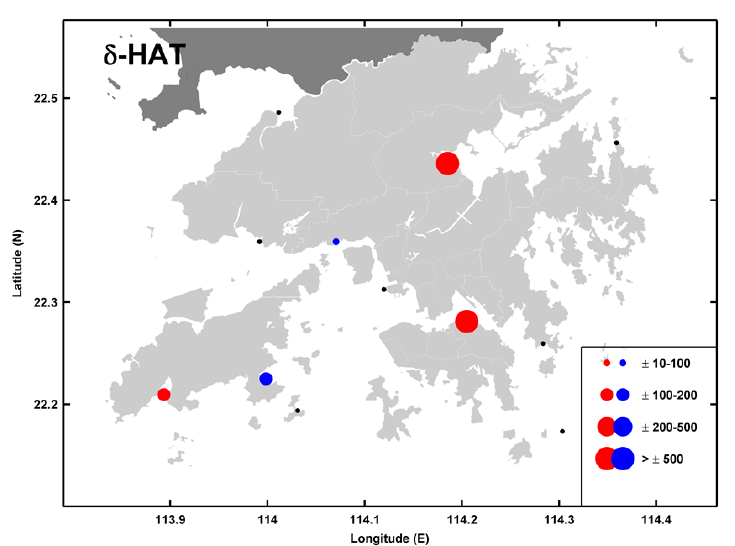
Figure 6. δ -HAT map for the Hong Kong tide gauge network [352]. Size of the markers shows the relative magnitude according to the legend, expressed in units of mm m-1. Red/blue colors indicate positive/negative TACs, and black markers indicate insignificant values.